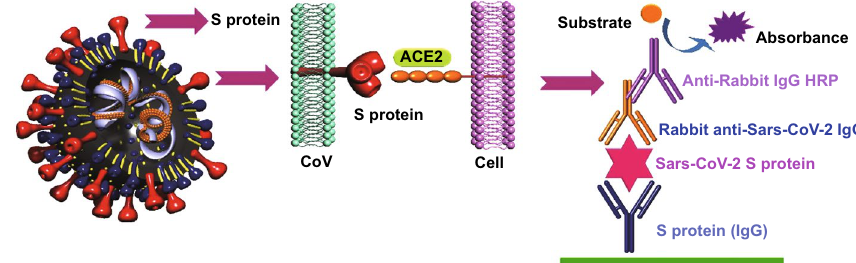
Fig. 5 Overview of ELISA techniques for the detection of